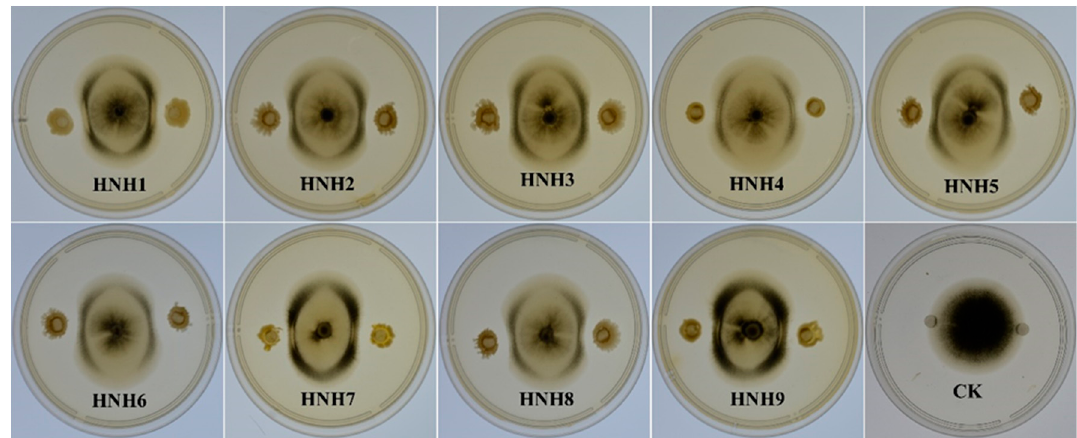
Figure 2. Antagonistic effect of endophytic Bacillus strains against VD-080.